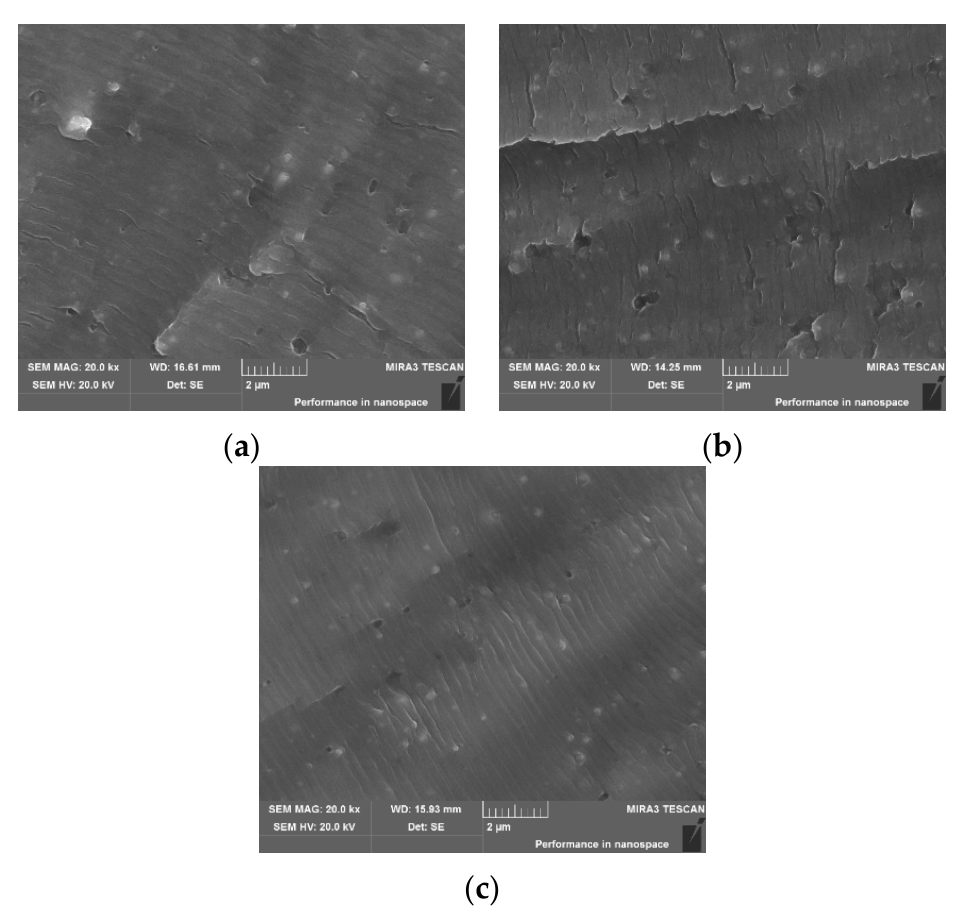
Figure 4. Fatigue crack expansion area: ( a ) T3; ( b ) AA; ( c ) CA.